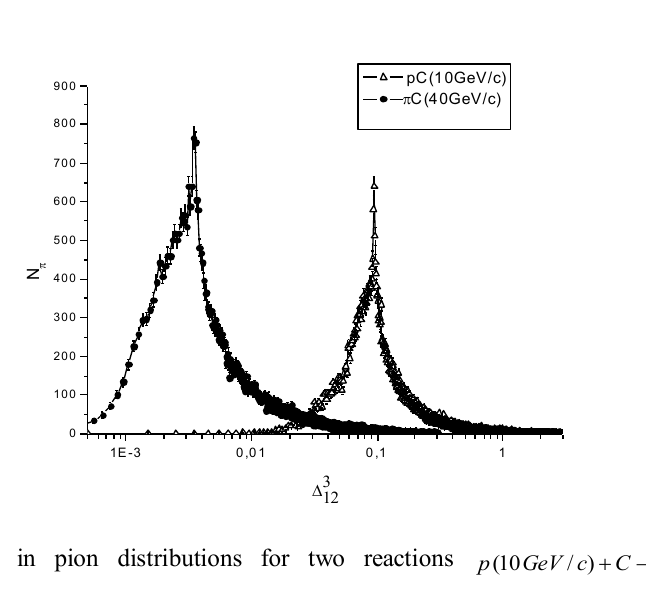
Fig. 4 Peaks in pion distributions for two reactions →+ CcGeVp )/10( and